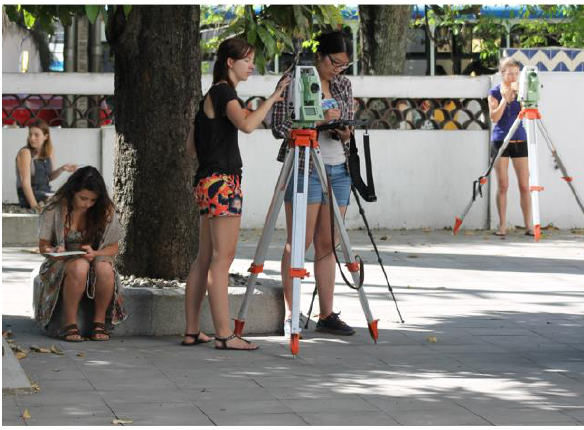
Fig.7 Hand drawings of Casa Cristo indicating the location of EDM targets, architectural details, measurments and generic field notes. Hand drawings’ author: Sabina Barrett-Ryan.